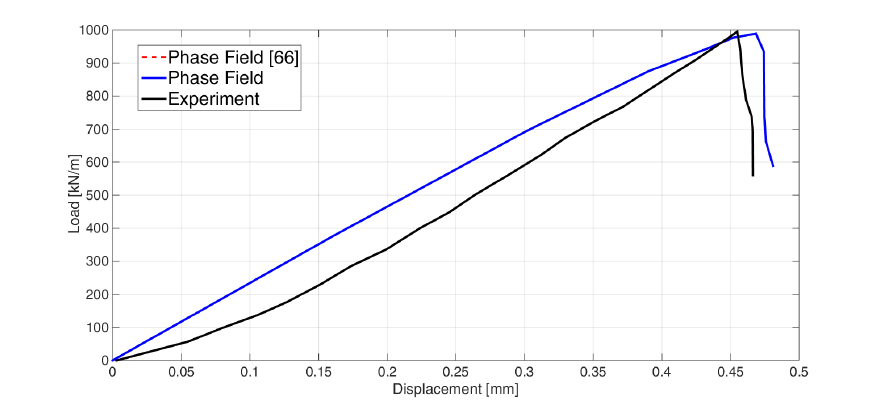
Figure 2. ( a ) Brazilian splitting test: loading condition. ( b ) Damage pattern of the specimen.